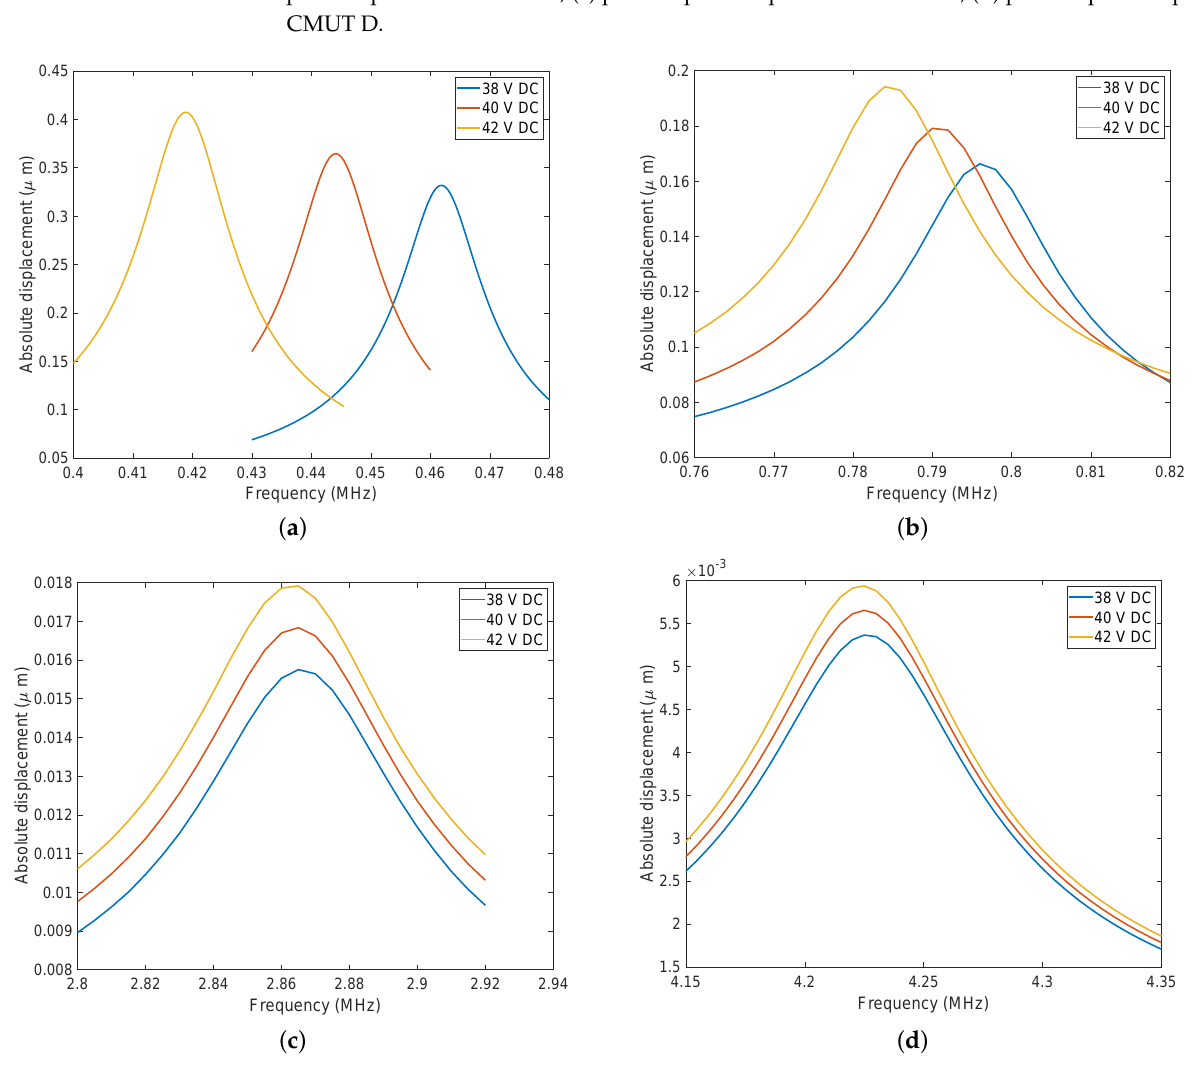
Figure 13. Frequency response of CMUTs.( a ) Frequency response of CMUT A; ( b ) frequency response of CMUT B; ( c ) frequency response of CMUT C; ( d ) frequency response of CMUT